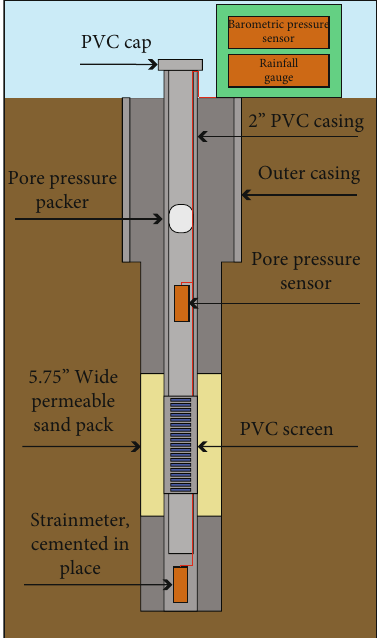
Figure 3: Cartoon of a borehole in the PBO observatory. Downhole sensors include pore pressure sensor and strainmeter. Barometric pressure and rainfall are measured at the